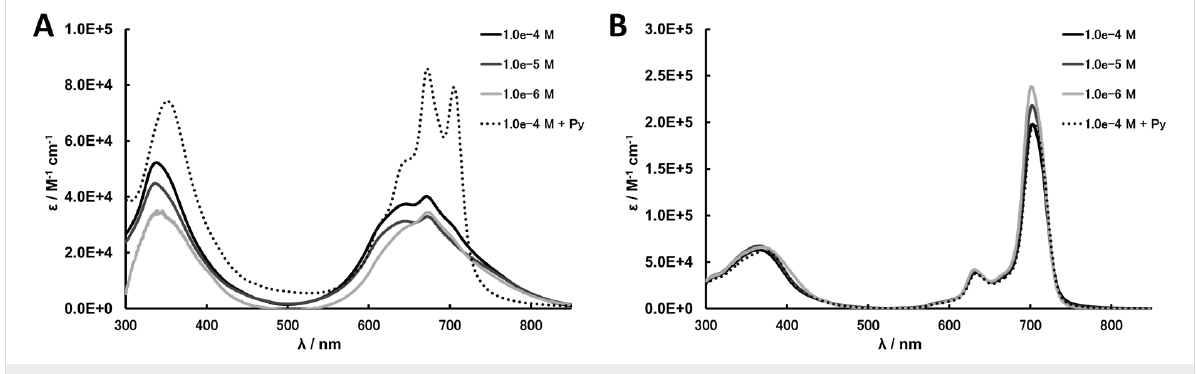
Figure 3: UV–vis spectra of 9 (A) and 5 (B).